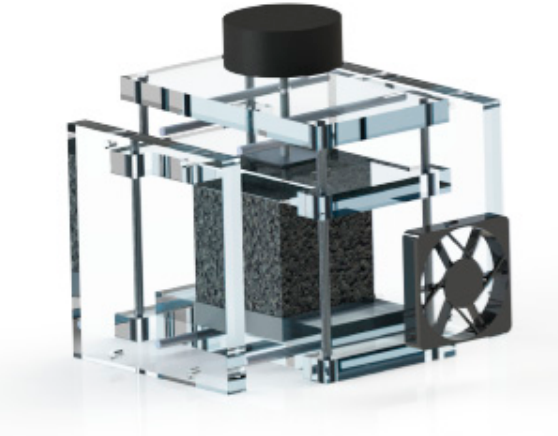
Figure 3. CAD modelling of the experimental set-up for the configuration with load.